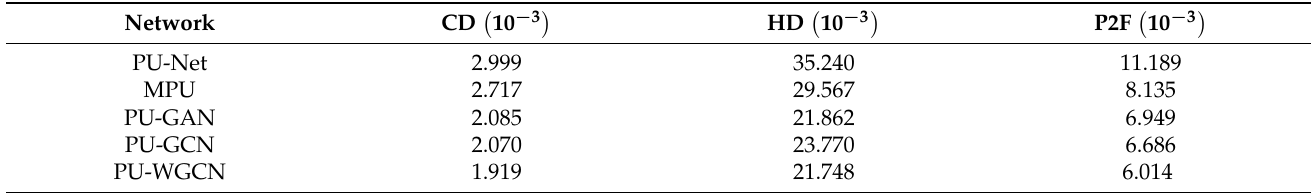
Table 2. Comparison of upsampling results for point cloud numbers from 512 to 2048.